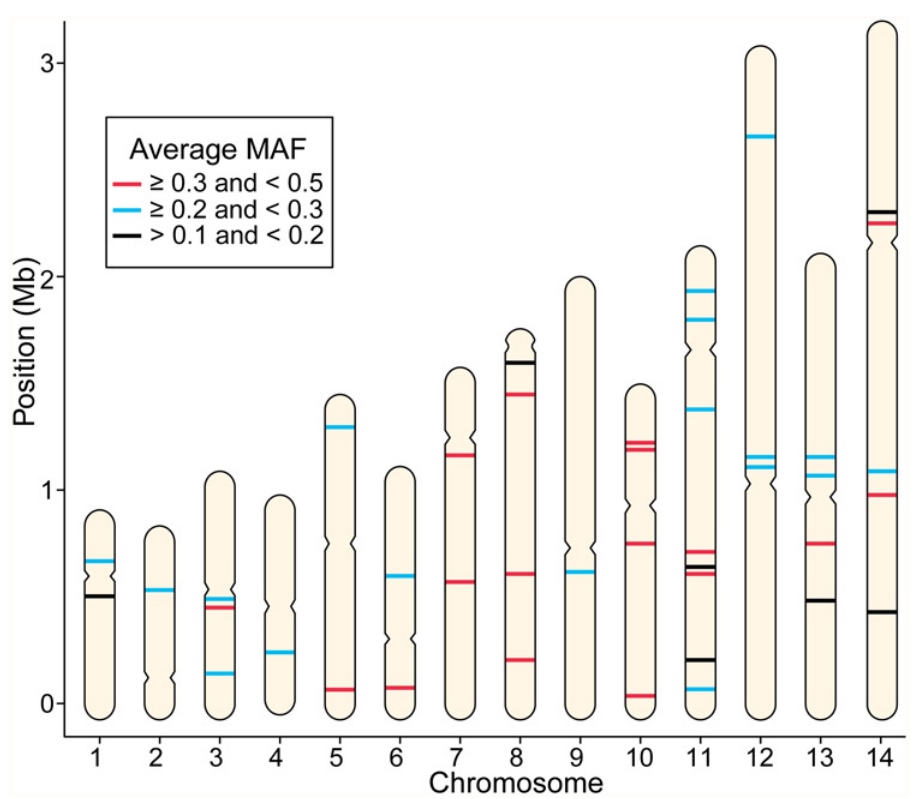
Fig 3. The 42-SNP barcode is distributed across the genome. The location of the 42 SNPs is illustrated on the 14 chromosomes of the P. vivax genome. SNPs are colored by their average minor allele frequency (AMAF) among the populations tested; 17 SNPs had AMAF (cid:1) 0.3, 18 SNPs had 0.3 > AMAF (cid:1) 0.2, and 7 SNPs had 0.2 > AMAF > 0.1 (S7 Table). Putative centromere locations are indicated by the pinched location on the perimeter of each chromosome [16].